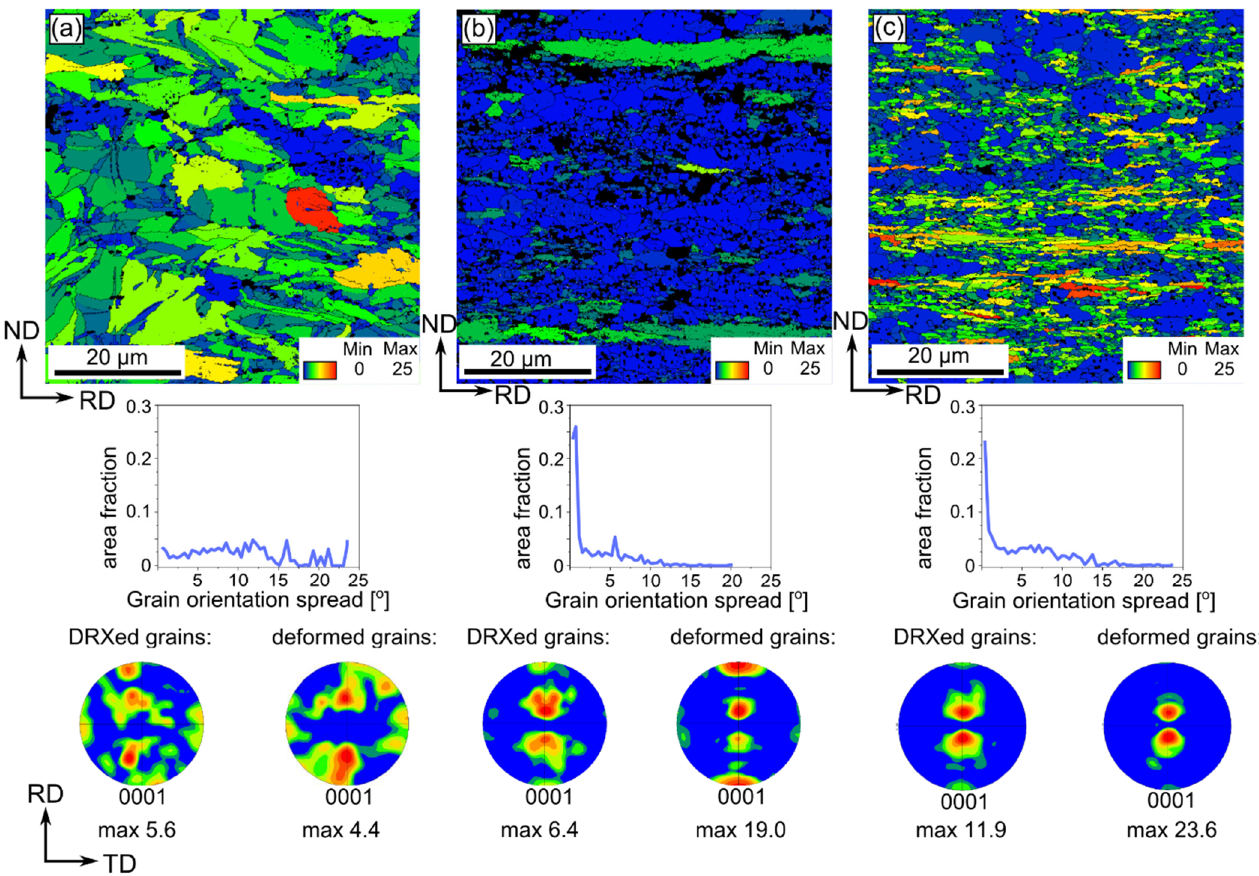
Figure 7. GOS maps with the parameter distribution and below (0001) pole figures of separate based on GOS parameter fraction of DRXed grains (GOS ≤ 5 ° ) and deformed grains (GOS > 5°) of the cold-rolled Zn-1Cu alloy with the reduction rates of 50% ( a ), 75% ( b ) and 90% ( c ).